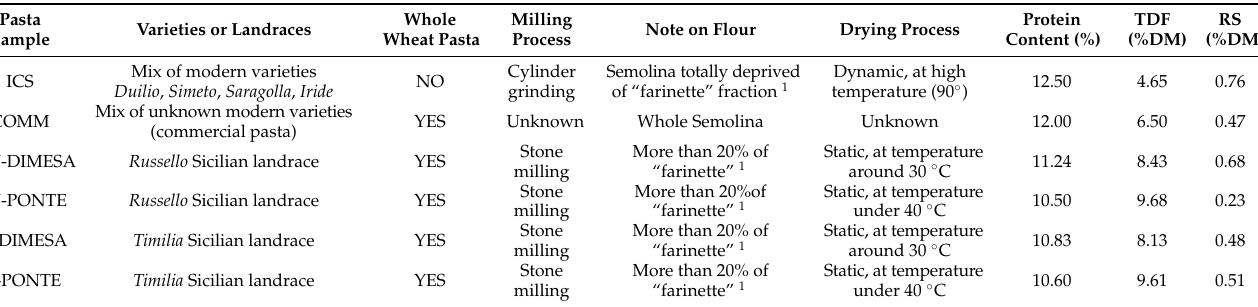
Table 2. Characteristics of samples of pasta